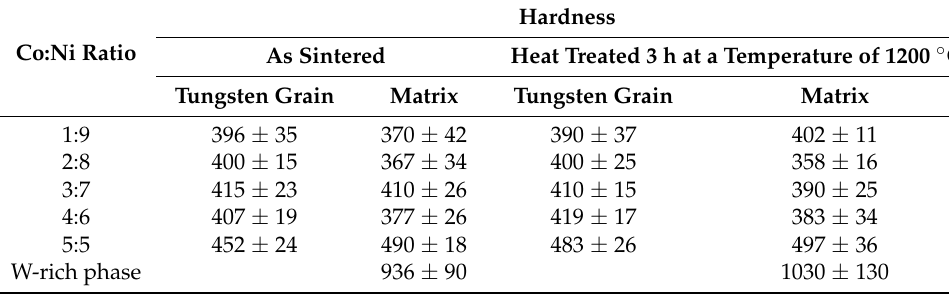
Table 8. Results of microhardness measurements.